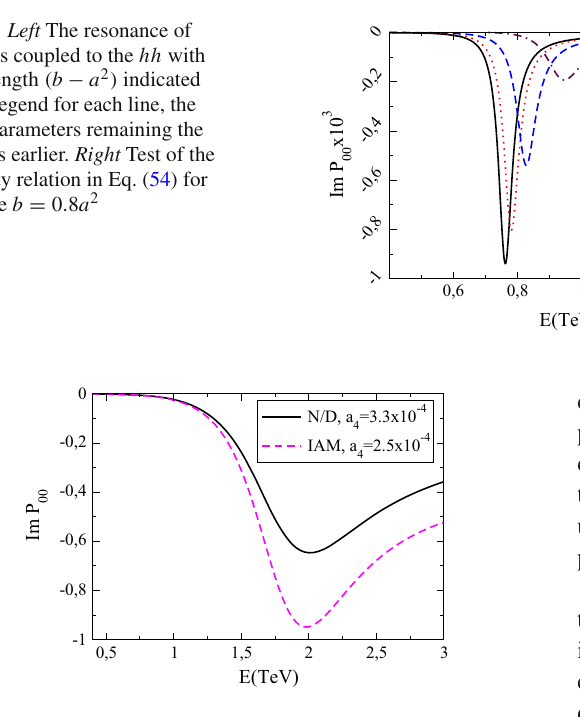
with a 2 − b , the matrix amplitude in Eq. (57) has as denomi- nator, in view of T ( 0 ) = 0, a slightly more complicated